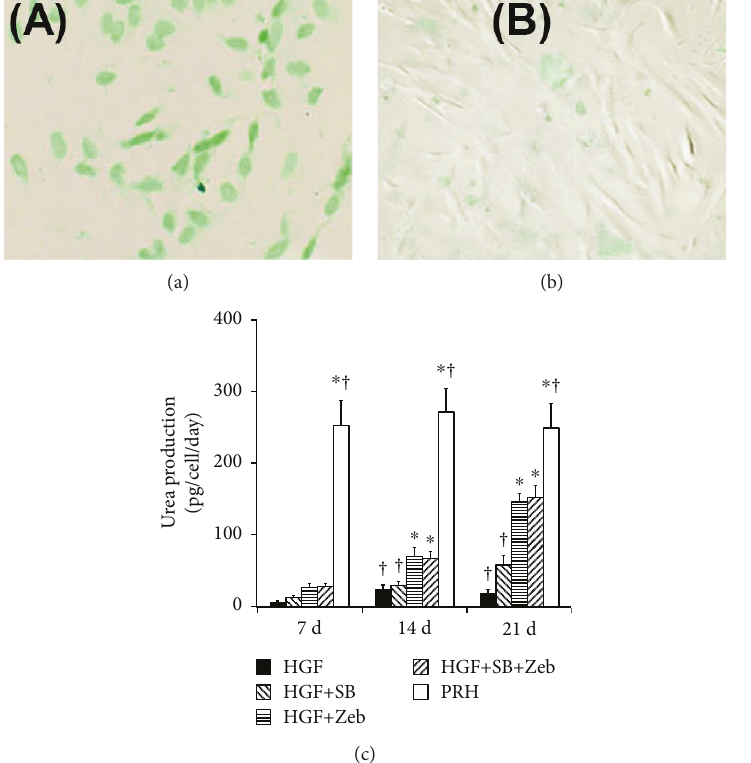
Figure 6: ICG metabolism and urea production. BMMSC-derived cells were positive for ICG after incubation in ICG solution for 30 min (a). ICG in the di ff erentiated cells was released after 6h (b). Zebularine treatment induced urea production in the cells (c). Asterisk indicates p < 0 05 compared with the HGF group; dagger indicates p < 0 05 compared with the zebularine